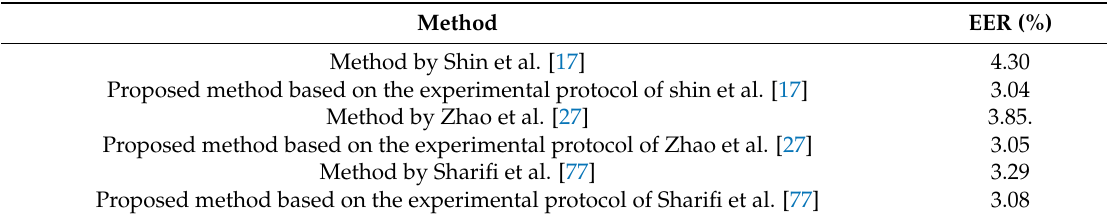
Table 9. Comparison between the recognition method suggested by this study and the methods of other preceding studies with the CASIA-Iris-Distance